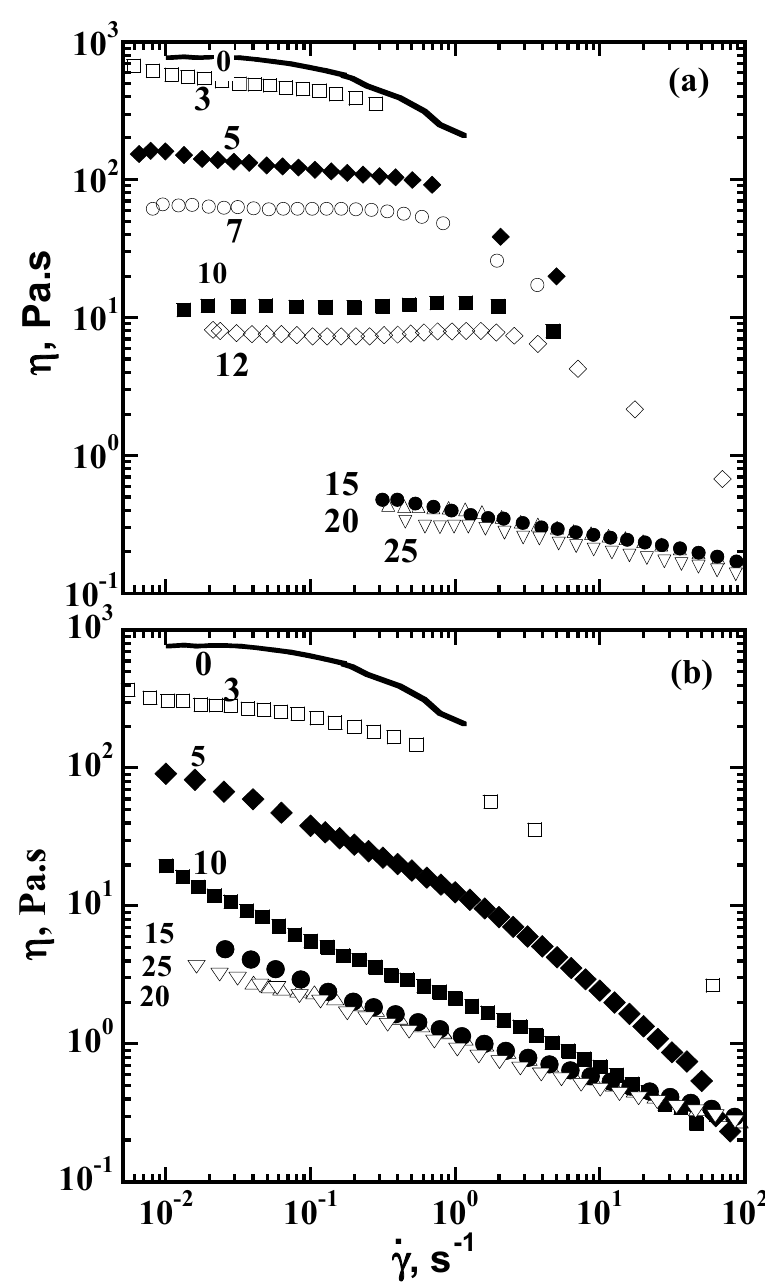
Figure 16. Effects of addition of ( a ) α -CD and ( b ) β -CD on the steady shear viscosity of 3% HASE associative polymer solutions. Numbers correspond to the moles of cyclodextrin per moles of hydrophobe. Reproduced from [15] with permission, copyright John Wiley & Sons, 2013.